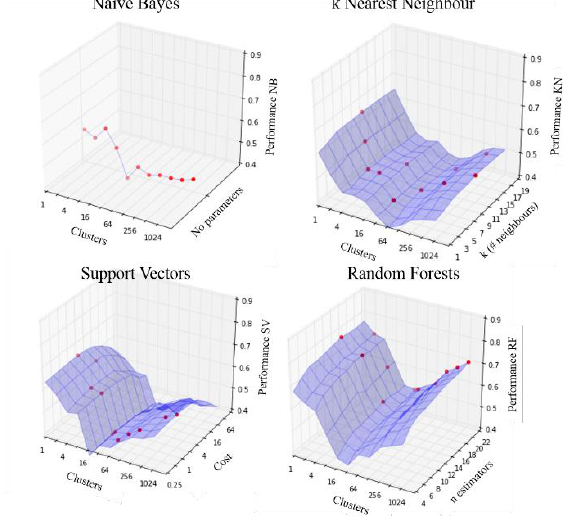
Figure 3. Comparison of the mean accuracies over three trials, i.e. varied calibration cluster locations, of the cross validation for each MLA as functions of the number of clusters and parameter values to be tested as specified in Table 4. Red dots indicate best performance and parameter value that resulted in the values used in the prediction evaluation, which are summarized in Table 5.